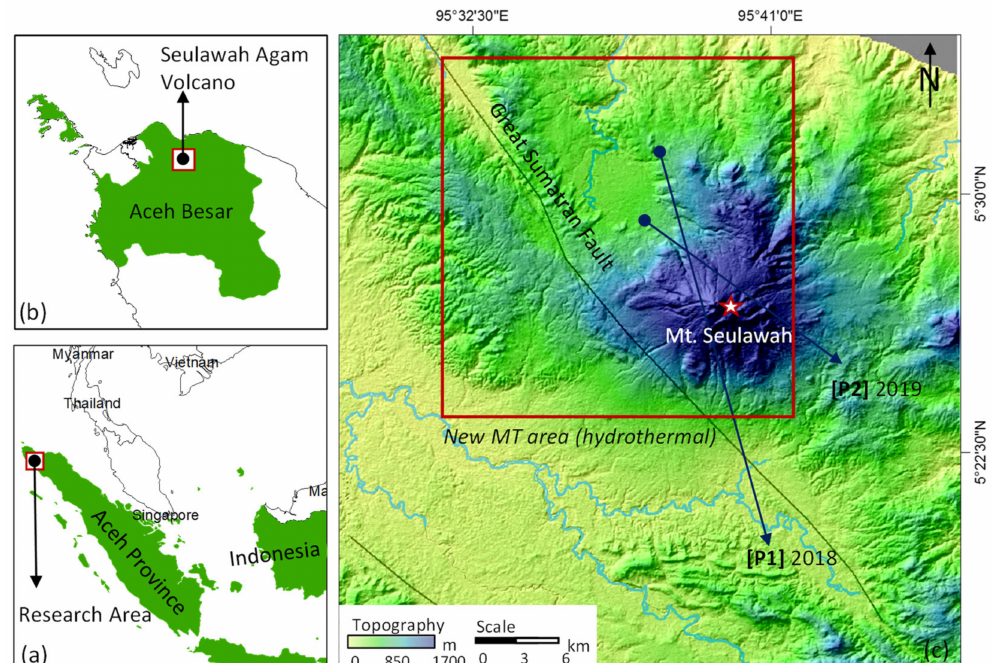
Figure 1. ( a ) Map of the measurement location showing the Seulawah Agam volcano in northernmost of Aceh Province, ( b ) the volcano is located in Aceh Besar, 85 km from Banda Aceh, while ( c ) is the topography of the volcano that located in the area close to the Great Sumatran Fault (GSF). P1 is present the Profile 1 of 2D MT measurement evaluated in 2018 [36], while P2 is Profile 2 that was published in 2019